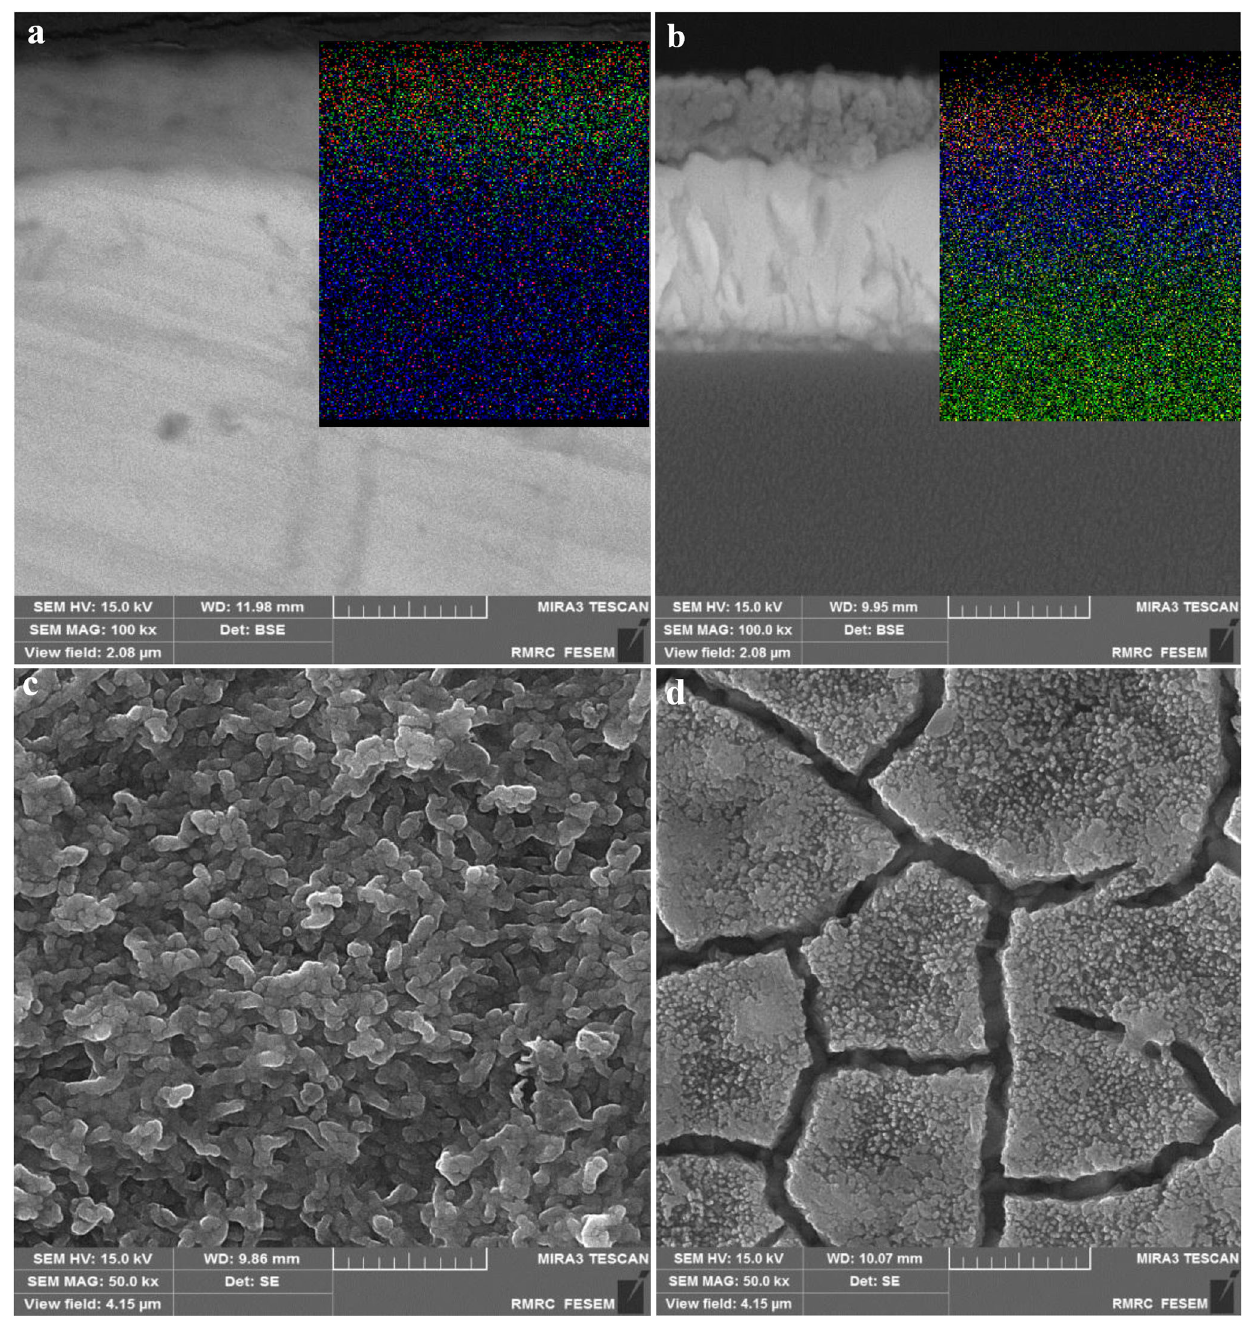
Fig. 1 Cross-sectional and top-view FE-SEM images of the electrodes (thin- fi lm semiconductors). a FeS 2 thin fi lm electrodeposited on Cu substrate (the inset is elemental mapping image of Fe (red), S (green) and Cu (blue) atoms; the scale bar is 500 nm). b Fe 2 O 3 thin fi lm electrodeposited on FTO glass (the inset is an elemental mapping image of Fe (red), Sn (blue), Si (green) and O (yellow) atoms; the scale bar is 500 nm). c , d are top-view of the FeS 2 and Fe 2 O 3 thin fi lms, respectively (the scale bar is 1 Facile improvement of the decolorization performance of the (1) At the bias extremes (±300 V), the decolorization ability of the reactor (DP) declined, reaching their limiting value, i.e., reactor by applying an appropriate electrostatic bias to the DP in the absence of electrode but presence of photon and photoelectrode is an intriguing fi nding of this research. Due to oxygen (Supplementary Fig. 4, control experiments). In other single-electrode nature of the system (lack of counter electrode), words, by applying very large biases, the reactor behaves the circuit is not complete and no external current passes like a setup without photoelectrode. This behavior can be through the system. This means that without consuming rationalized through repulsive forces exerting between dye electricity, just by applying an electrostatic bias to the photo- species and electrode surface: e.g., in the case of positive electrode, the reactor ’ s performance increases signi fi cantly. bias ( + 300 V), owing to the strong electrostatic repulsion between the cationic dye and extremely positively charged